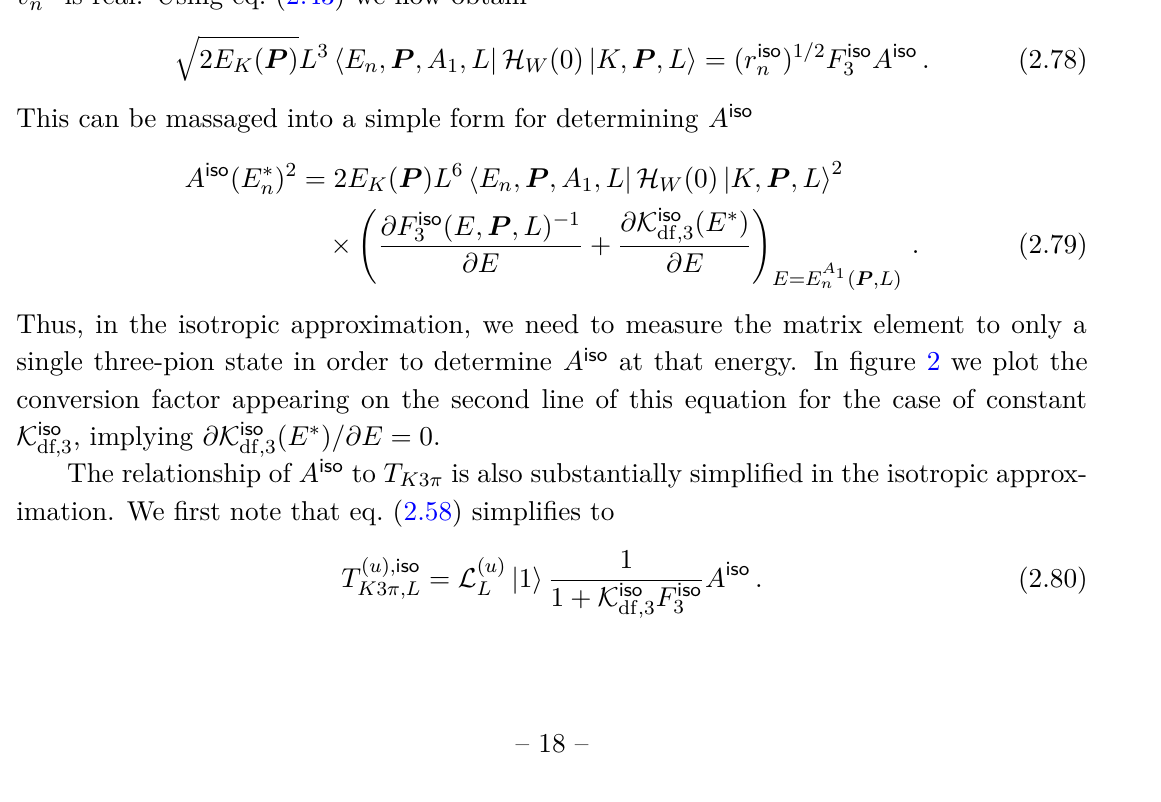
Figure 2 . Plot of the conversion factor appearing in eq. (2.79) (rescaled as indicated by the plot label) in the vicinity of the three-particle threshold for the case of constant K iso is plotted versus energy E for P = 0 and mL = 6 . The two-particle K matrix, entering F iso determined by keeping only the scattering length, a , in the effective range expansion. The three curves correspond to three values of the scattering length, as indicated by the legend, and each unfilled marker corresponds to the ground-state energy for the corresponding ma value when K iso 0 . In particular, the blue square corresponds to the non-interacting limit. The fact that the conversion factor is unity in the latter case indicates that the non-interacting matrix elements are equal in finite and infinite volume, up to a trivial normalization. More generally, once the scattering length is determined, these types of curves allow one to directly relate — within the isotropic approximation — any value of measured three-particle energy (horizontal axis) to a matrix element conversion factor (vertical